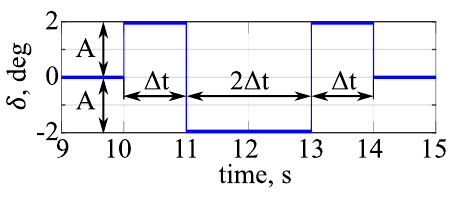
Figure 3. Multi-step input scheme.